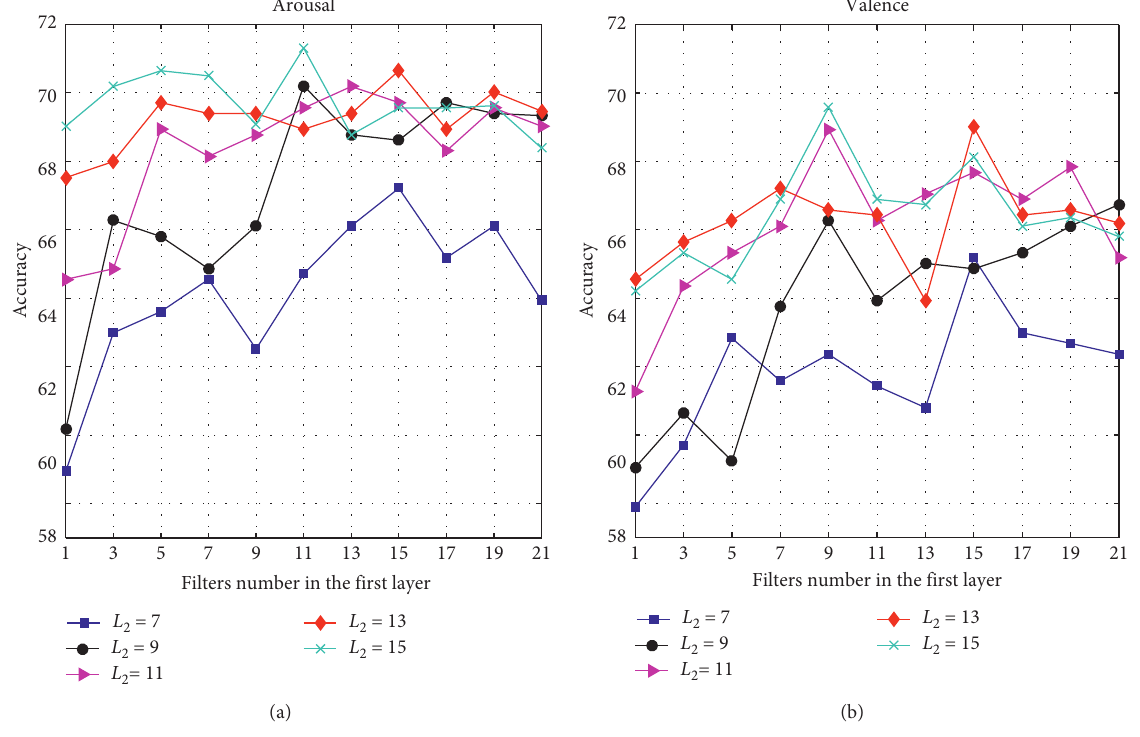
Figure 9: Emotion recognition accuracy with different numbers of filters in two dimensions. Given L changes with a varying number of filters in the first layer ( L different numbers of filters. (b) Recognition accuracy in the valence dimension with different numbers of